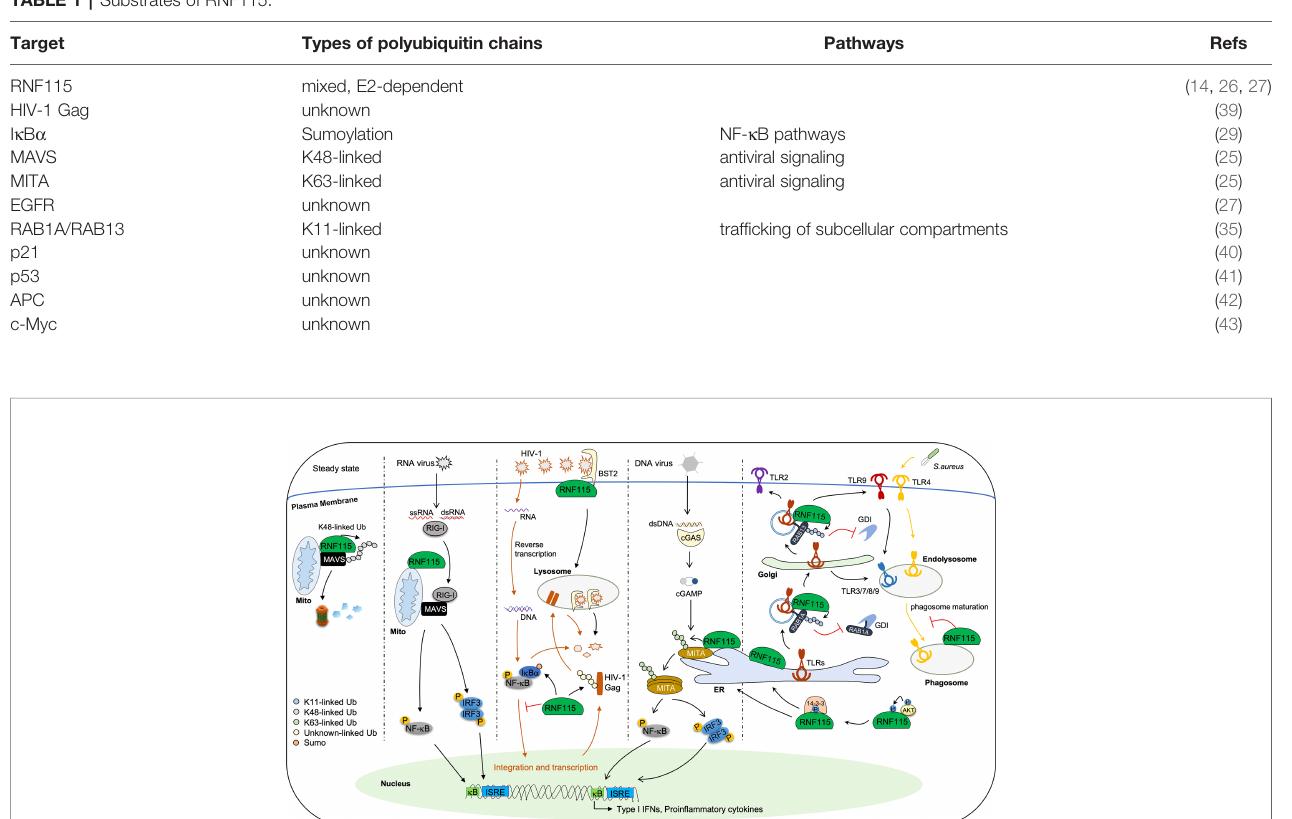
FIGURE 2 | The signaling pathways regulated by RNF115 in innate immunity. In steady state, RNF115 constitutively interacts with and catalyzes K48-linked ubiquitination of MAVS, leading to the proteasomal degradation of homeostatic MAVS. Upon infection with RNA viruses, RIG-I – MAVS interaction led to RNF115 dissociation from MAVS, thereby initiating downstream signal transduction. Moreover, RNF115 functions as a restriction factor for HIV-1 infection. Firstly, RNF115 interacts with BST2 to promote the newly synthesized HIV-1 particles on the plasma membrane for lysosomal degradation. Secondly, RNF115 directly catalyzes ubiquitination of HIV-1 Gag, leading to its lysosomal degradation independently on BST2. Thirdly, RNF115 targets I k B a for SUMOylation, inhibiting HIV-1-induced NF- k B activation and HIV-1 transcription. In addition, The 14-3-3 chaperones bind to AKT1-phosphorylated RNF115 and facilitate RNF115 localizing at the ER. RNF115 interacts with and induces K63-linked ubiquitination of MITA at ER during infection of DNA viruses, promoting aggregation of MITA and the production of type I IFNs and proin fl ammatory cytokines. RNF115 also interacts with TLRs and buds off the ER onto the coat protein complex II vesicles. RNF115 catalyzes K11- linked ubiquitination of RAB1A to inhibit the extraction of RAB1A by GDI1. In addition, RNF115 inhibits the post-Golgi traf fi cking of TLR2, TLR4, and TLR9 by catalyzing K11-linked ubiquitination on RAB13. Consequently, the traf fi cking of TLR4 from the Golgi apparatus to cell surface and the traf fi cking of TLR9 to cell surface en route to endolysosomes were inhibited. Finally, RNF115 also inhibits phagosome maturation during S. aureus infection.